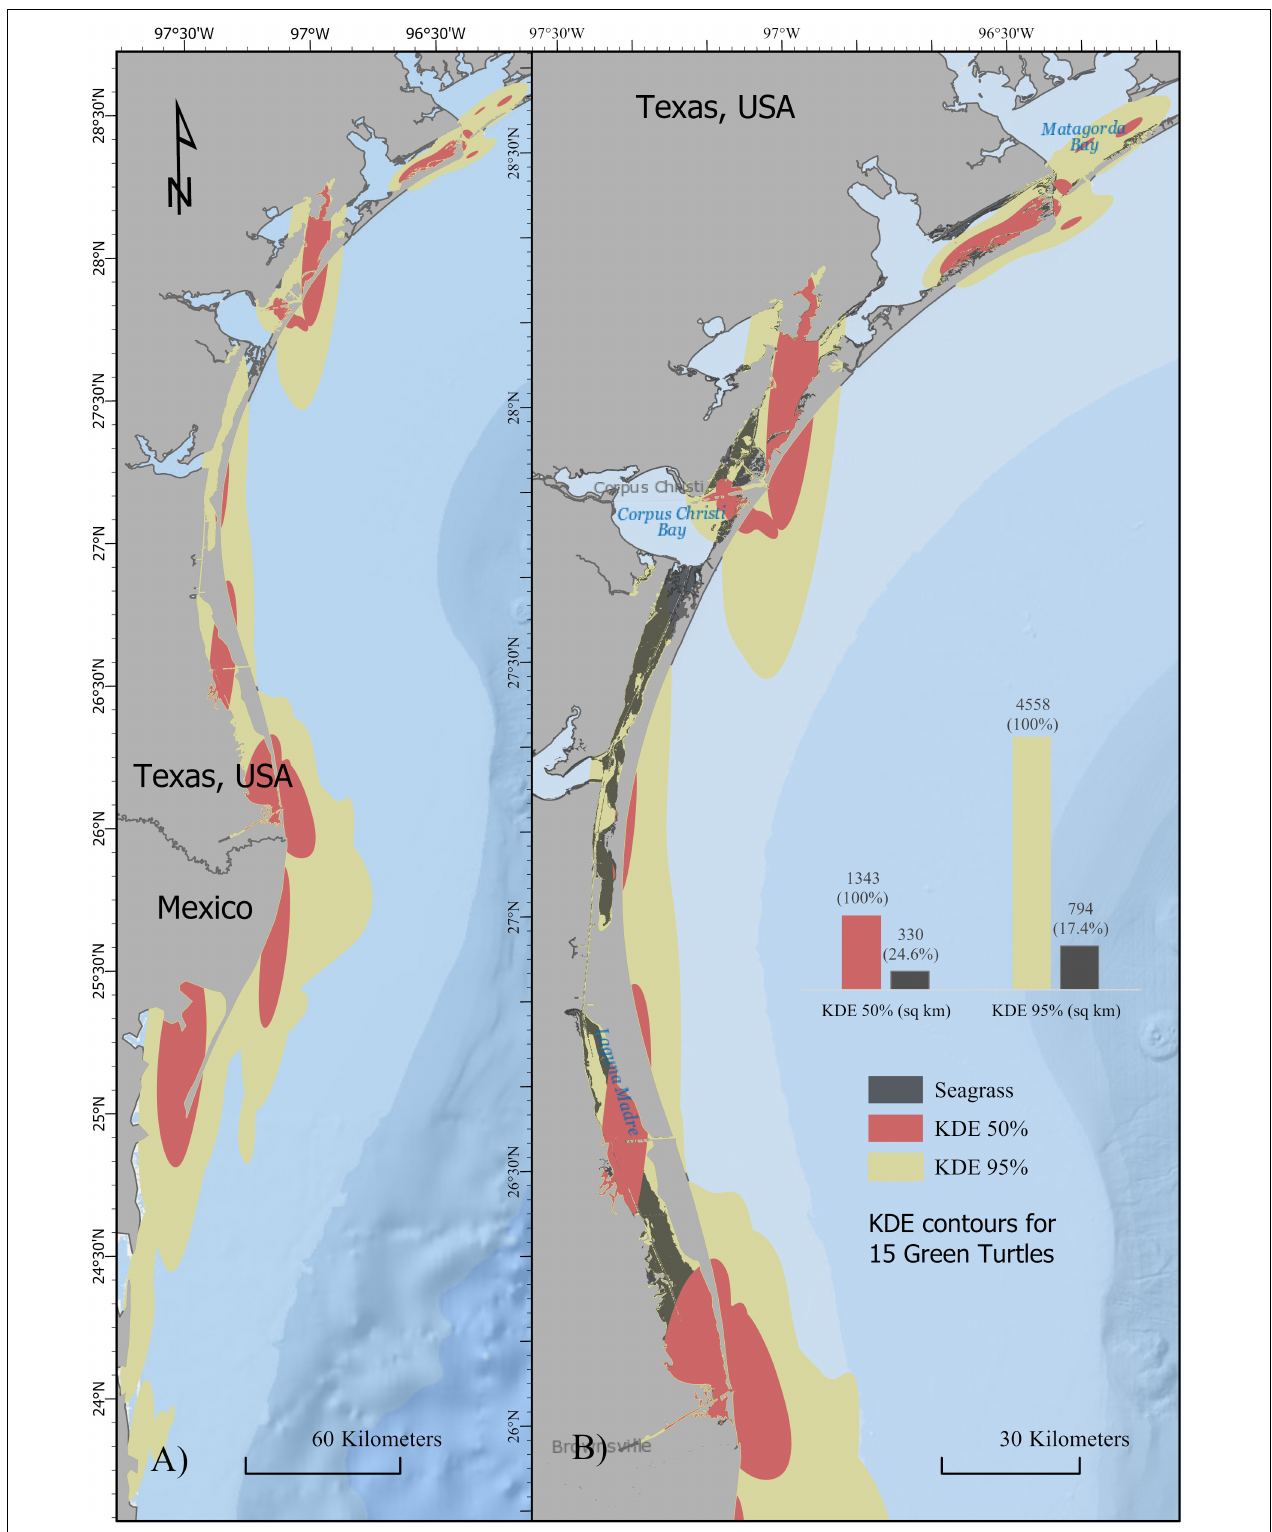
FIGURE 4 | Map of 50% (red) and 95% (yellow) KDE contours for juvenile green turtles satellite tracked in the northwestern Gulf of Mexico ( N = 15). (A) 50% and 95% contours for entire sample area, including winter residencies in Mexico. (B) 50% and 95% contours overlaid with seagrass bed locations (gray) in Texas (data not available for